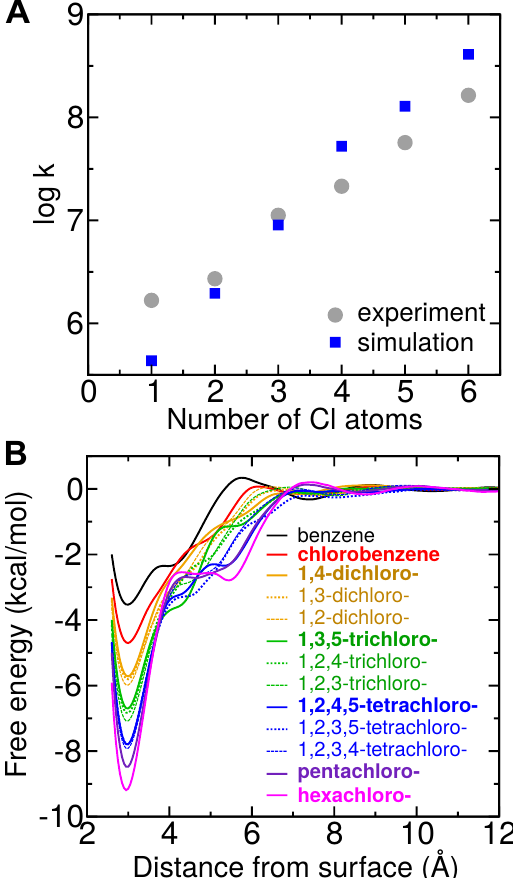
Figure 4. Molecular dynamics simulations of chlorobenzene adsorption on a model ZnO surface. ( A ) Comparison of adsorption coefficients determined from the experiment and predicted from the simulation. ( B ) Simulation-derived free energy as a function of distance between each chlorobenzene molecule and model ZnO surface. Compound names shown in boldface were those considered in the experiments and are plotted in panel A. While isomers with the same chlorine number had similar free energy profiles, we calculated small ( < 0.4 kcal/mol) but statistically significant differences. Zoomed-in plots of the free-energy minima, including error bars, can be found in Figure S3 of the Supplementary